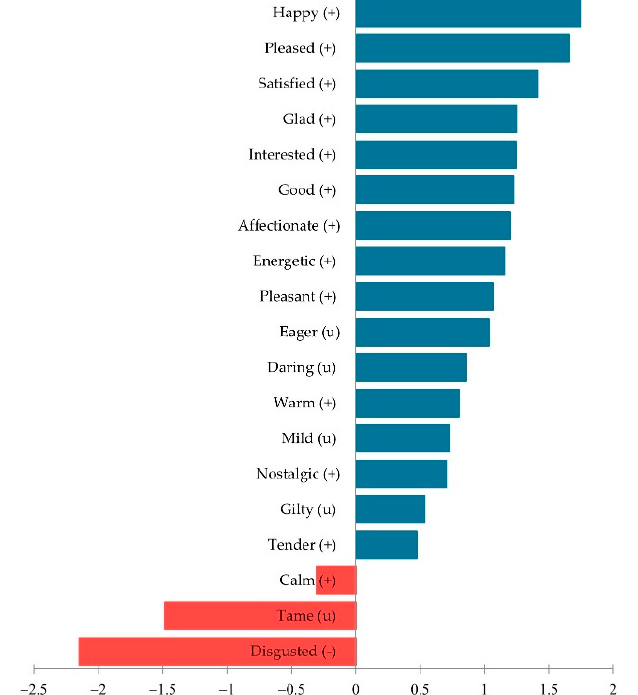
Figure 5. Mean impact in willingness to buy for each significant emotion on CATA analysis: (+), positive emotion; ( − ), negative emotion; (u), neutral emotion.